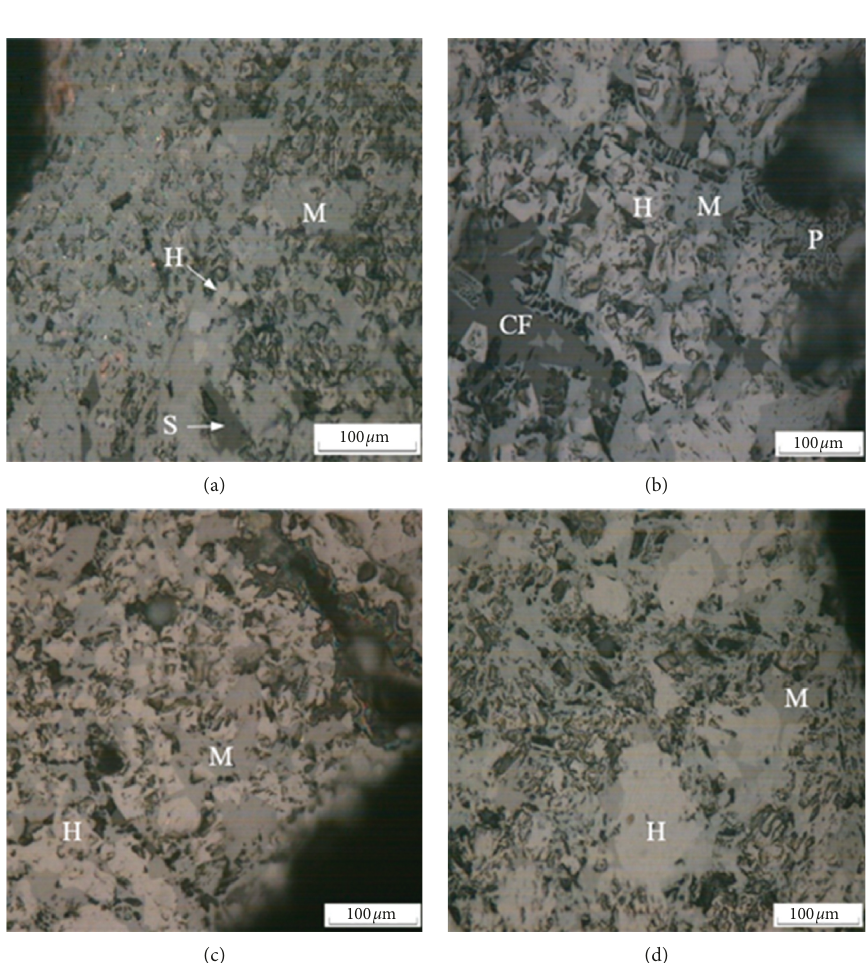
Figure 5: Phase diagrams of finished sintered ores with different oxygen enrichment loads: (a) 0; (b) 0.97; (c) 1.93; (d) 2.9. H: hematite; M: magnetite; P: perovskite; CF: calcium ferrite; S: calcium